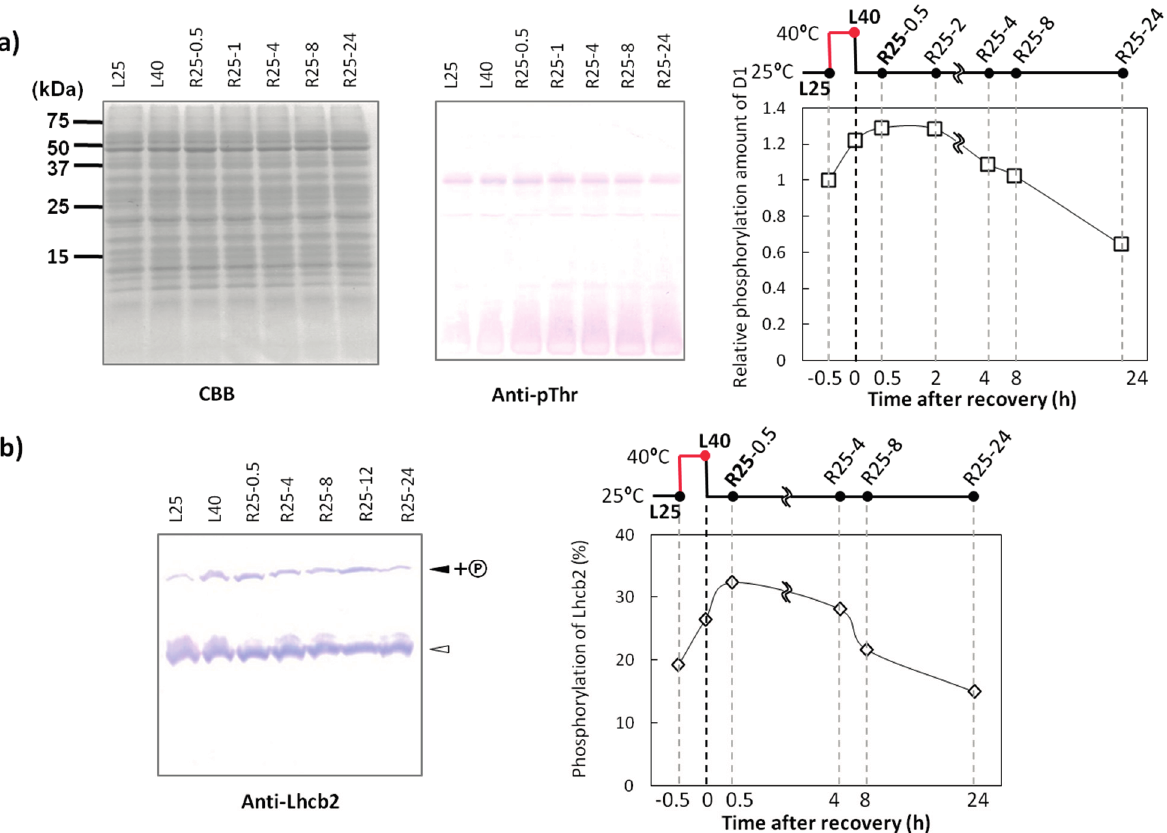
Figure 3. D1 and Lhcb2 were dephosphorylated during the 8 h recovery. ( a ) Proteins in the thylakoid membranes were subjected to SDS-PAGE and subsequent immunoblotting using specific phospho-threonine antibodies. Relative phosphorylation levels of D1 proteins are shown at right. x -axis is for the time after recovery from heat stress at 40 °C in light; ( b ) Thylakoid proteins were separated using Phos-tag™ SDS-PAGE and analyzed by immunoblotting with anti-Lhcb2 antibody. Filled arrowhead and open arrowhead shows the phosphorylated and non-phosphorylated proteins, respectively. Right panel represents the ratio of phosphorylated and non-phosphorylated Lhcb2. x -axis is for the time after recovery from heat stress at 40 °C in